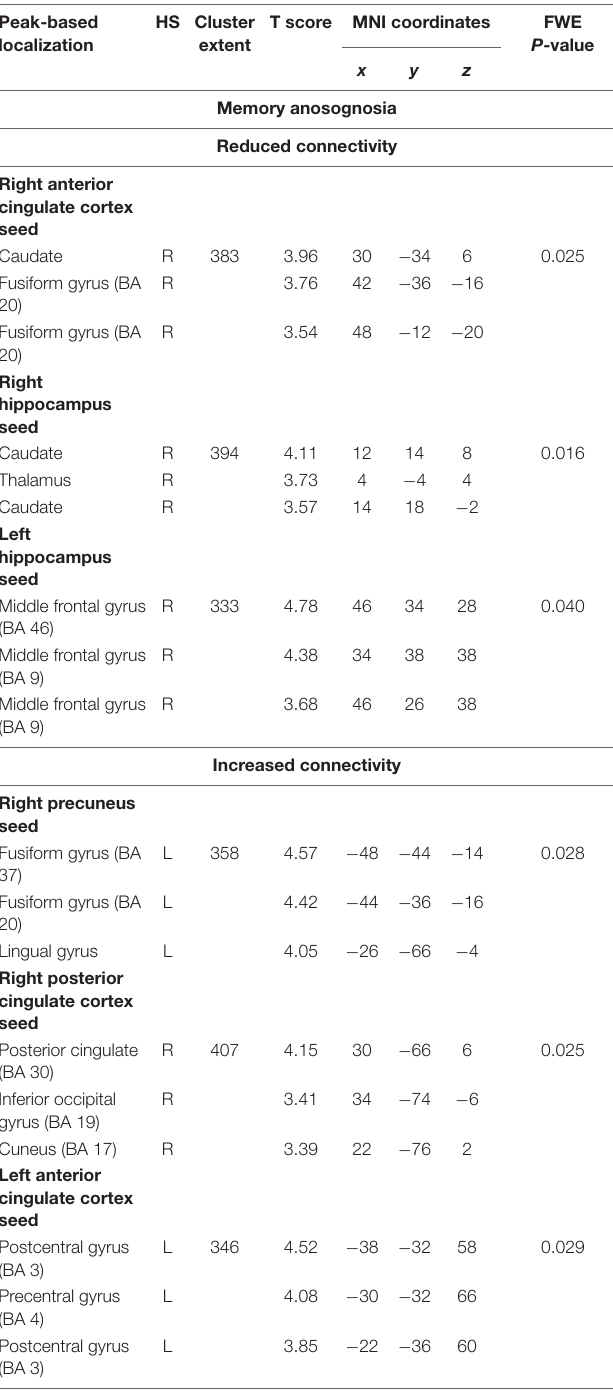
TABLE 3 | Neural correlates of memory anosognosia emerging from functional-connectivity patterns obtained via seed-based analysis. Peak-based